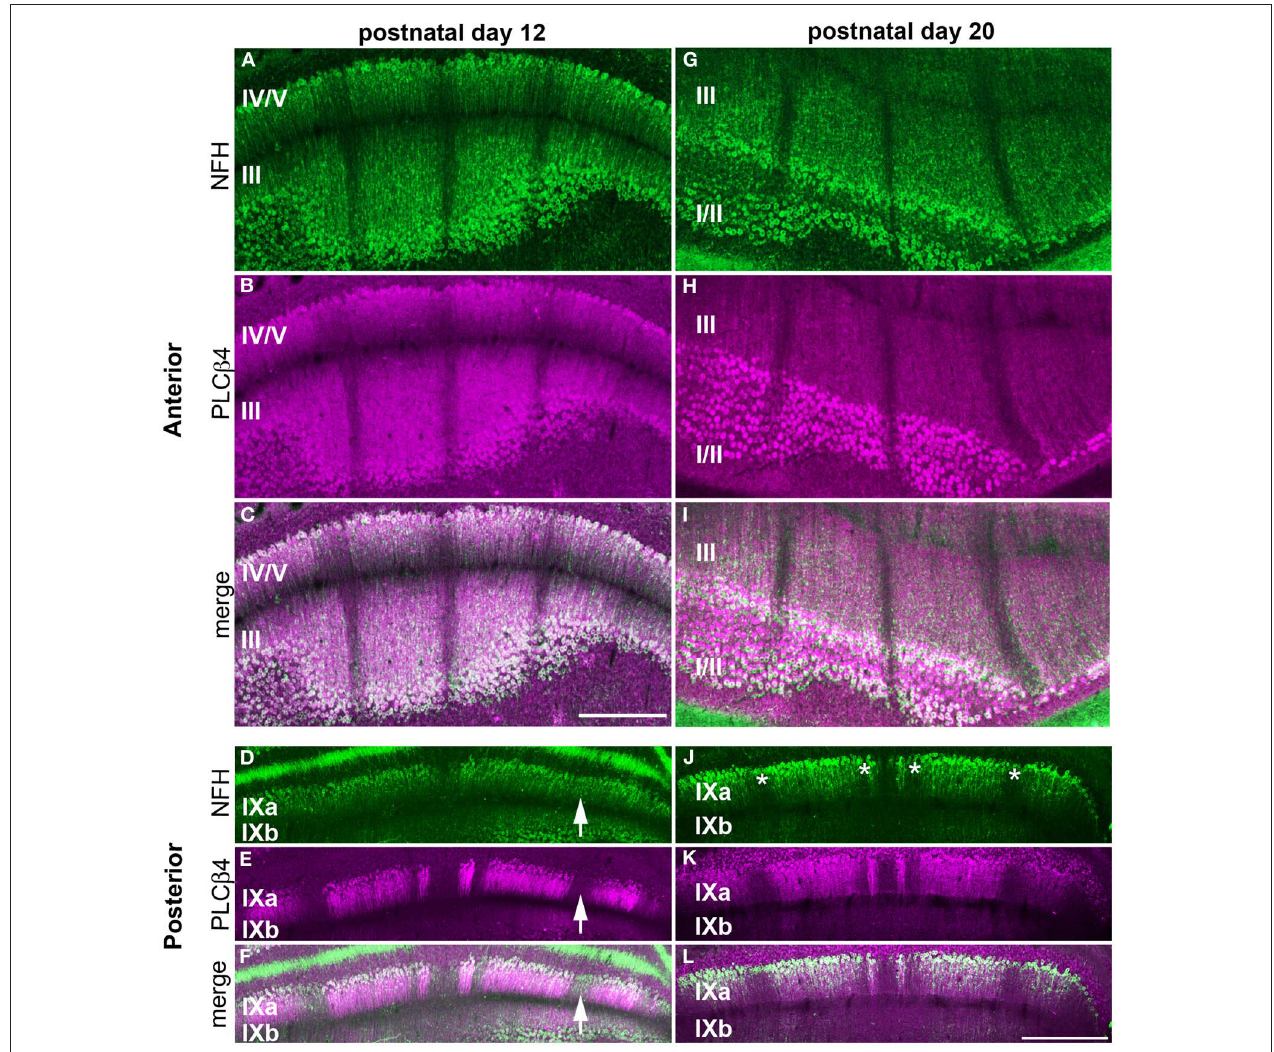
FIGURE 7 | NFH and PLCß4 have a complex zonal relationship. NFH (green) and PLCß4 (magenta) have corresponding patterns in the anterior lobules at P12 (A–C) and P20 (G–I) . (D–F) In the posterior cerebellum, the widespread expression of NFH overlaps with PLCß4